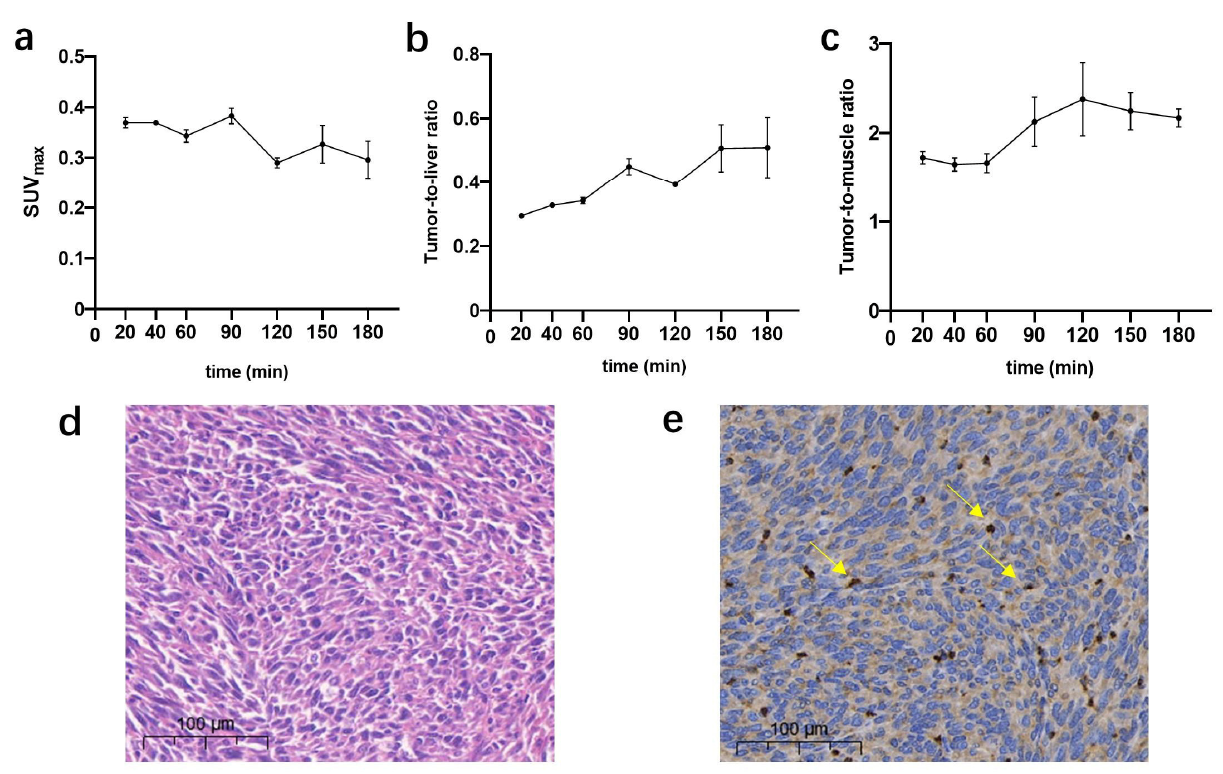
Figure 4. PET-CT uptake data of SUVmax ( a ), tumor-to-liver ratio (T/L) ( b ), and tumor-to-muscle ratio (T/M) ( c ) of xenografts at serial time points. ( d ) Hematoxylin and eosin (H&E) staining of PANC02 tumors (magnification, × 10). ( e ) Immunohistochemical staining of PANC02 tumor xenografts using an PD-L1-alpha antibody (yellow arrows indicate PD-L1-positive cells) (magnification, ×10).